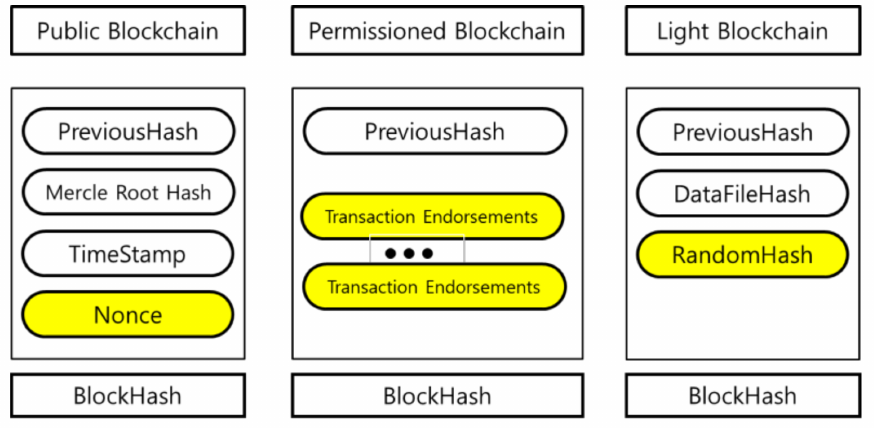
Figure 2. Light Blockchain Architecture.